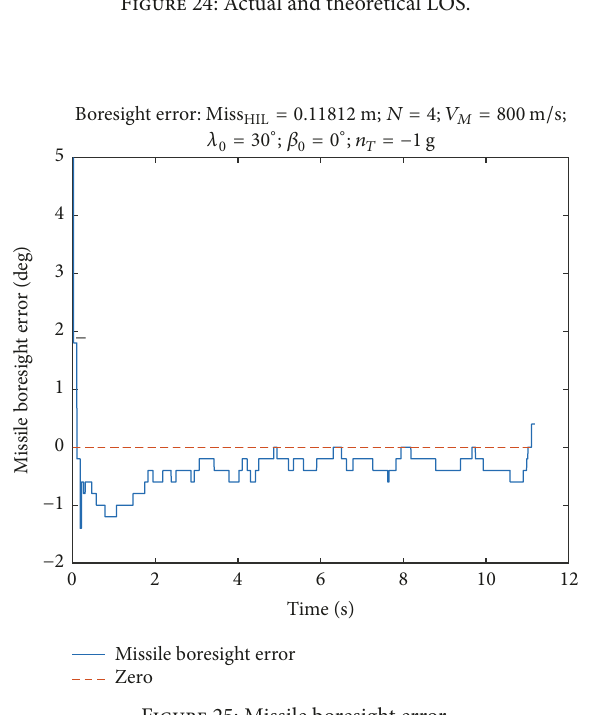
Figure 25: Missile boresight error.